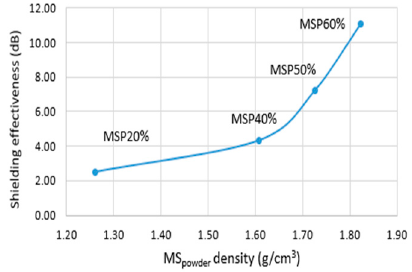
Figure 21. SE dependence of content of iron scale flakes. Frequency—23 GHz.